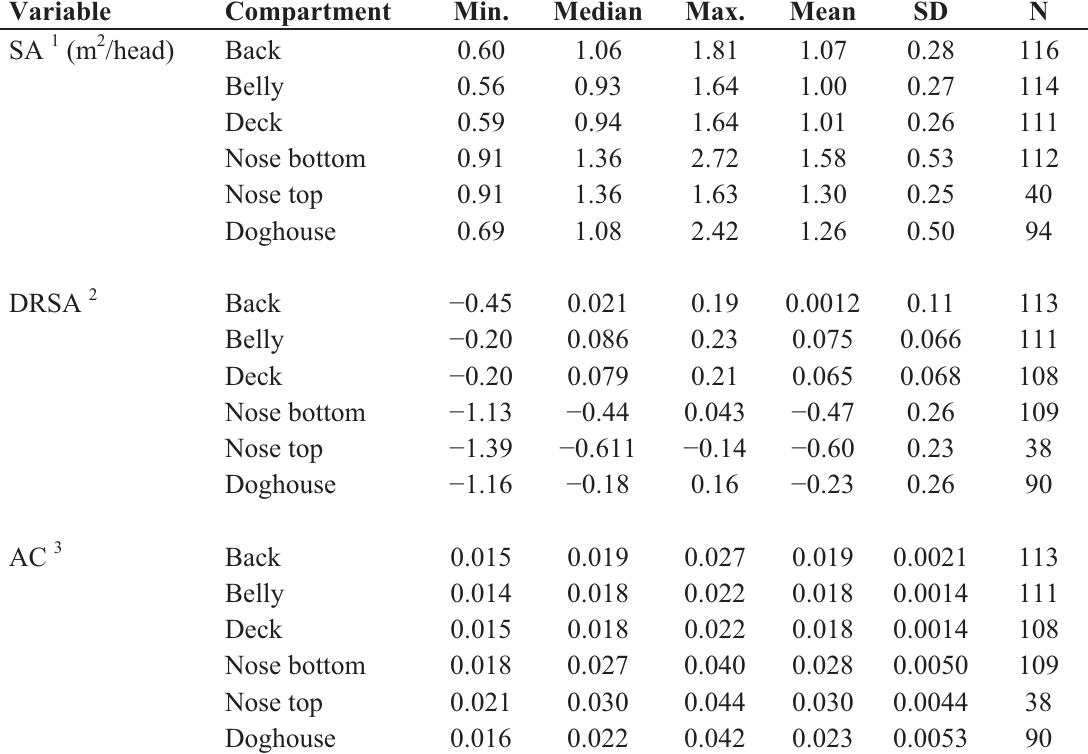
Table 5. Space allowances (m 2 /head) for cattle on tri-axle trailers that were unloaded at feed, water and rest stations in Thunder Bay, ON.